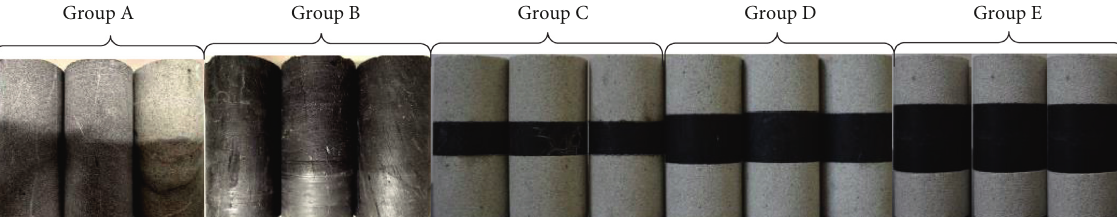
Figure 2: Standard coal-rock composite sample.